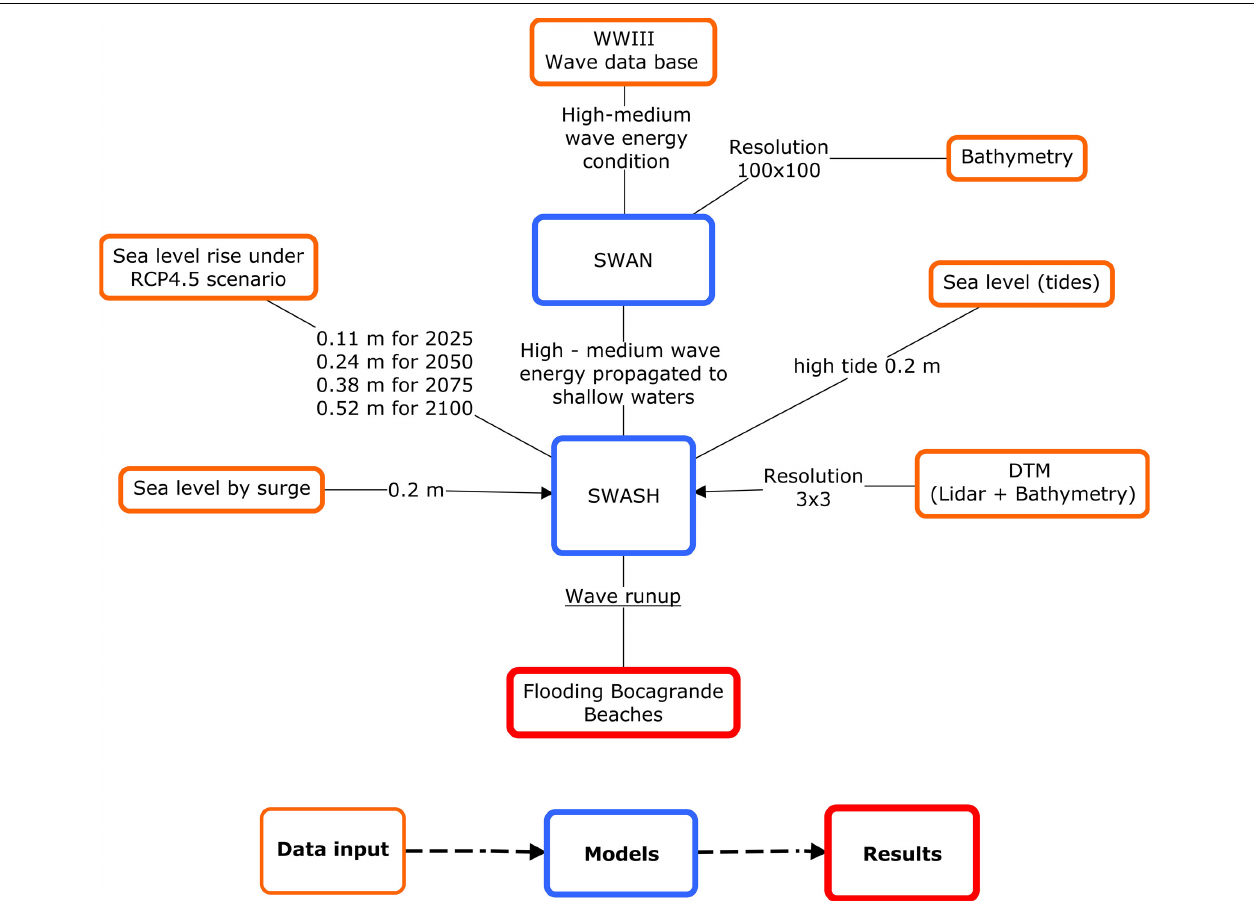
FIGURE 5 | Schematic representation of the approach followed in the